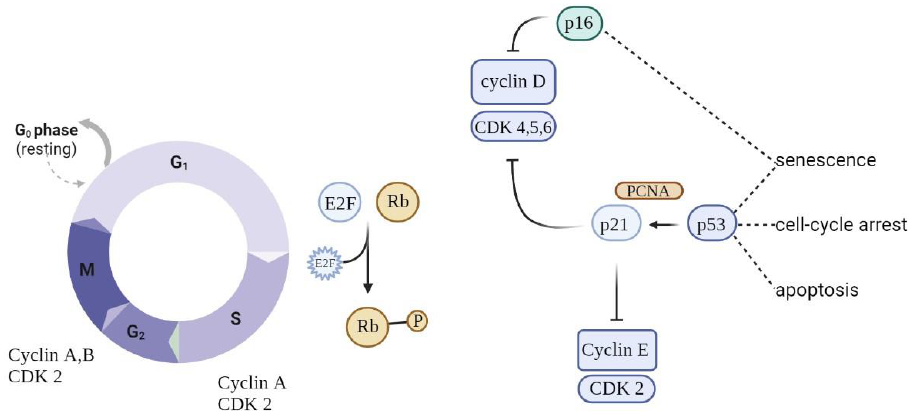
Figure 3. Schematic of cell cycle regulation (partial). To progress through the G1 phase, cyclin and CDKs should be set up and further phosphorylated. CDK inhibitors (CDKIs) halt cyclins from acting as cell cycle breaks. A close connection between cyclins, CDKs, and CDKIs is essential for correct cell cycle progression.